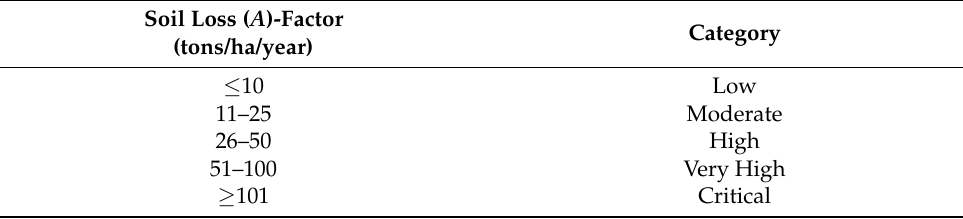
Figure 4. New P factor in Cameron Highlands derived from the study [33]. Table 4. Establishment of soil loss class category adapted from this study [33].